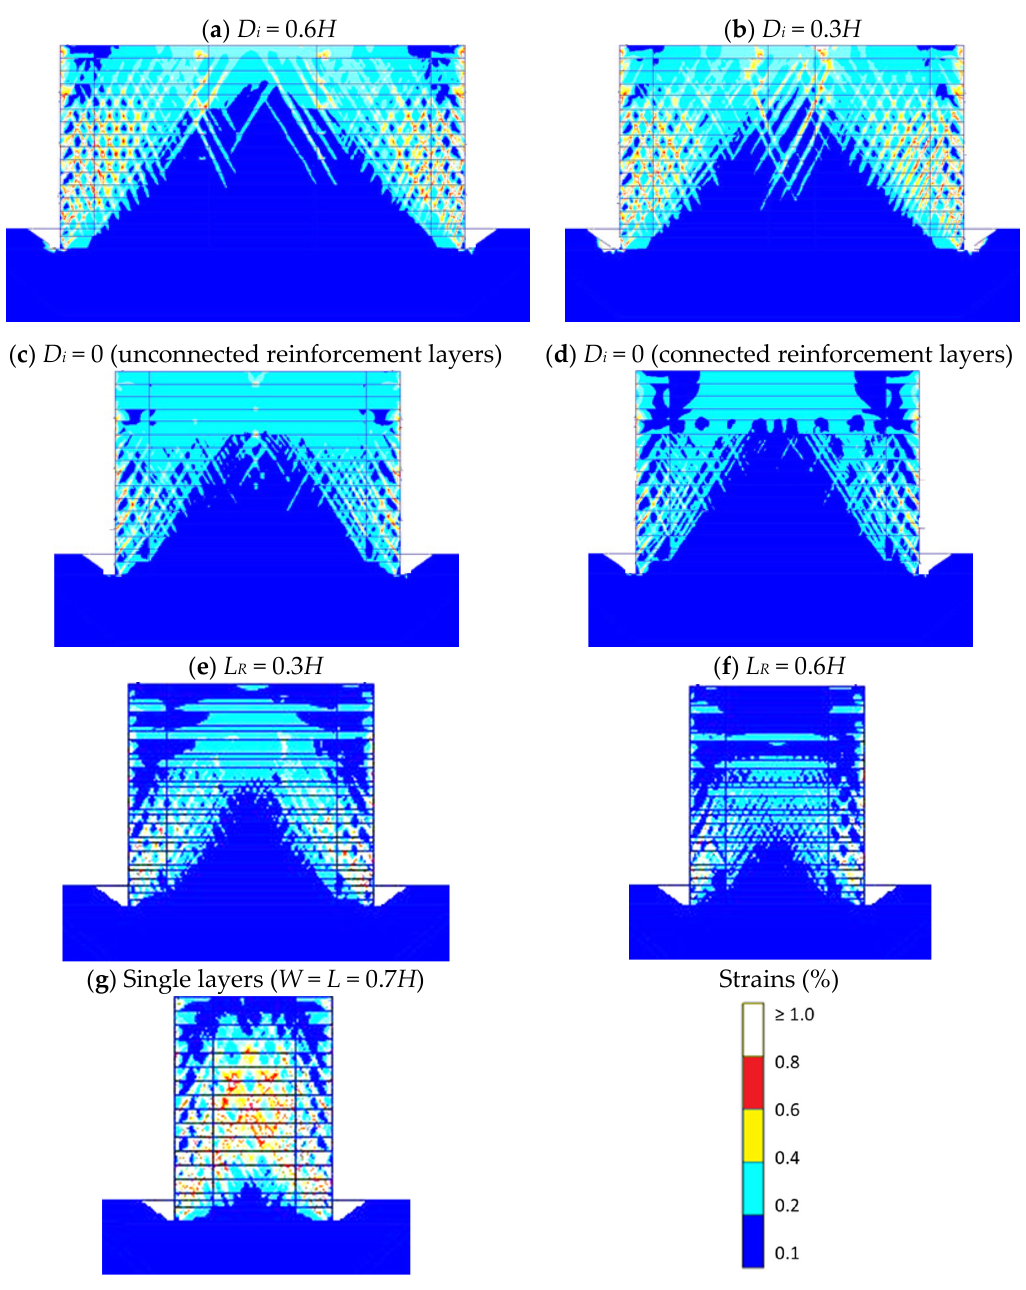
Figure 8. Shear strain contours at end of construction (EoC) for walls with different interaction distance ( D i ) between the back of the reinforced soil zones for opposite walls. Note: results ranging from 0 to 1%.